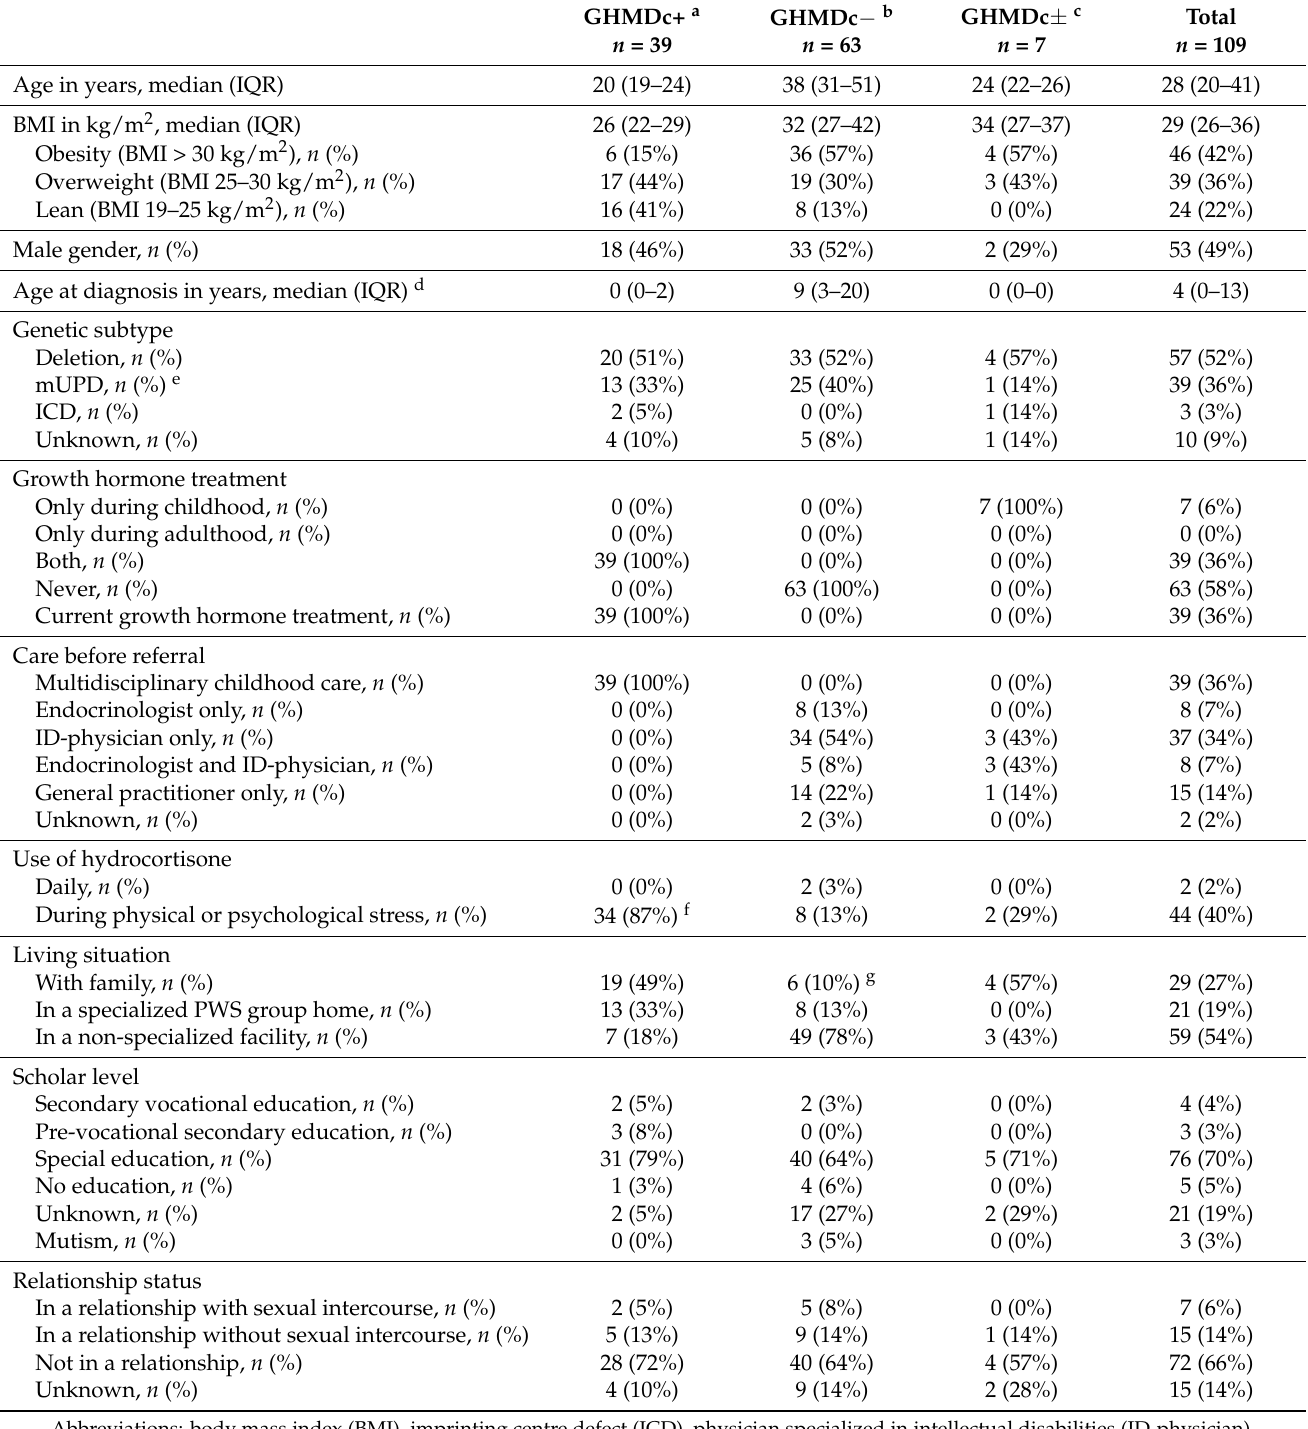
Table 1. Baseline characteristics of 109 adults with Prader-Willi syndrome according to GHMDc